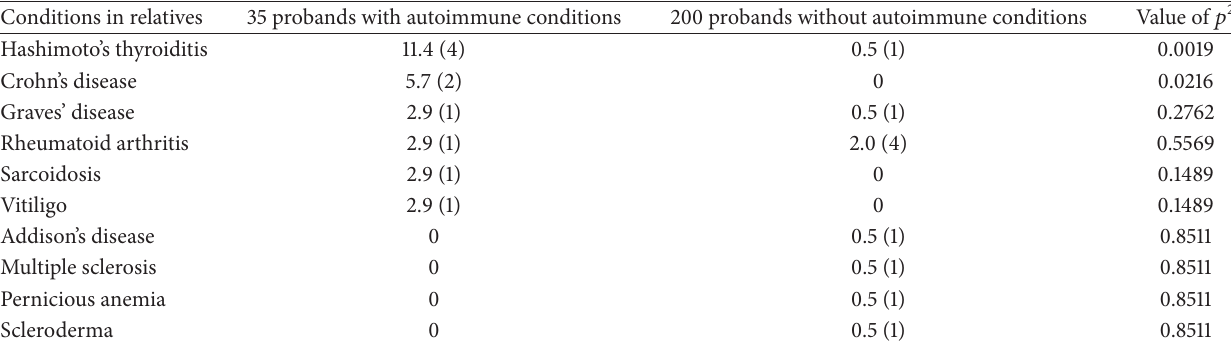
Table 3: Autoimmune conditions in 18 first-degree relatives of 235 hemochromatosis probands 1 .